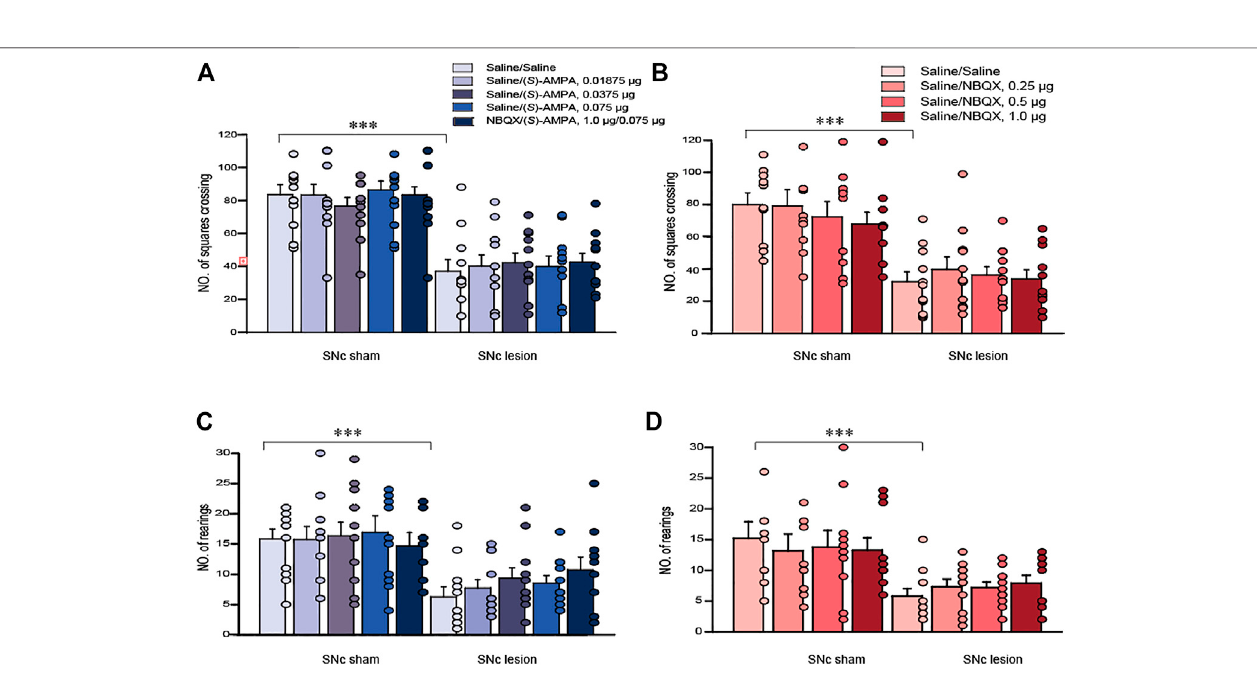
FIGURE 3 | The effects of 6-OHDA lesions and the intra-LHb microinjections of ( S )-AMPA and NBQX as the AMPARs agonist and antagonist, respectively, on spontaneous locomotor activity in the OFT. Unilateral SNc lesions decreased the number of squares crossed (A, B; horizontal movement) and rearings (C, D; vertical movement) in rats compared to that in sham-operated ones. Intra-LHb injections of ( S )-AMPA, NBQX/( S )-AMPA or NBQX did not alter the number of squares crossed (A,B) or rearings (C,D) relative to the saline/saline injections in either sham-operated or 6-OHDA lesioned rats. *** p < 0.001 vs . sham-operated rats; two-way ANOVA followed by Bonferroni ’ s test. Data are represented as means ± SEM; n = 10 – 12 rats/group.